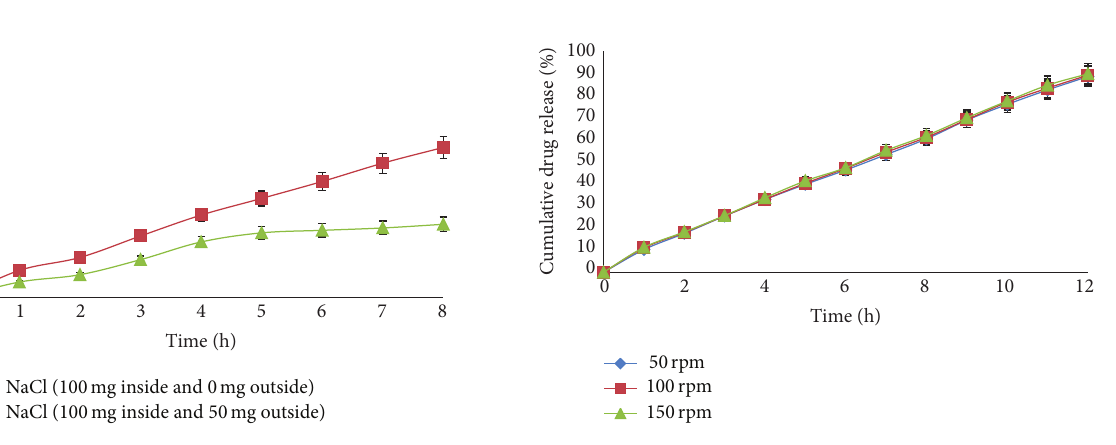
Figure 6: Dissolution profile of F 18 showing effects of agitational